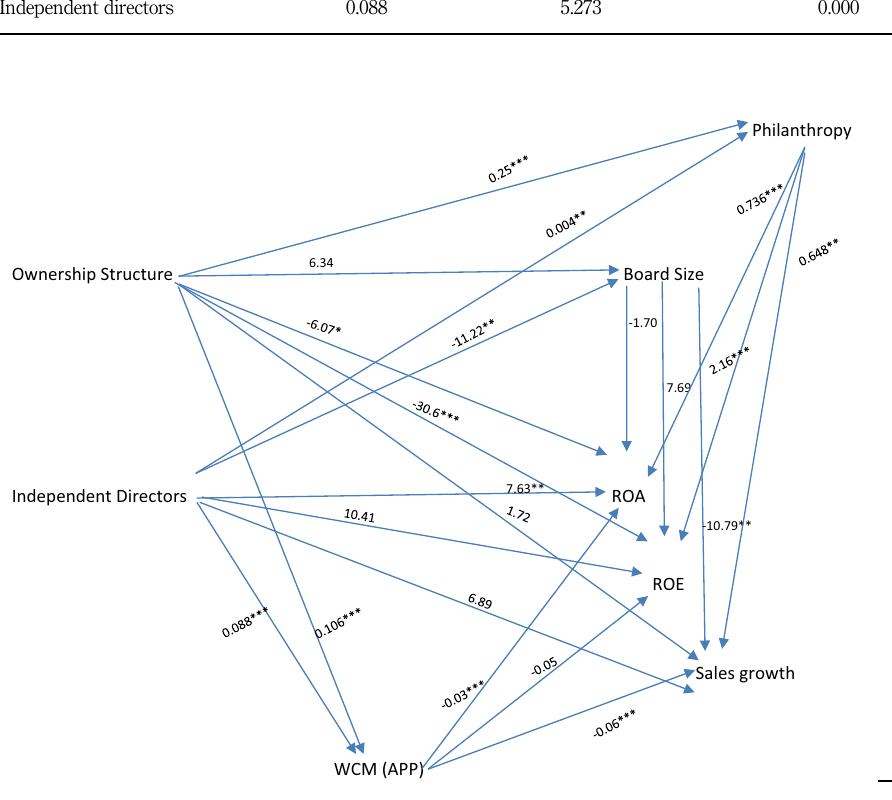
Table 4. The impact of